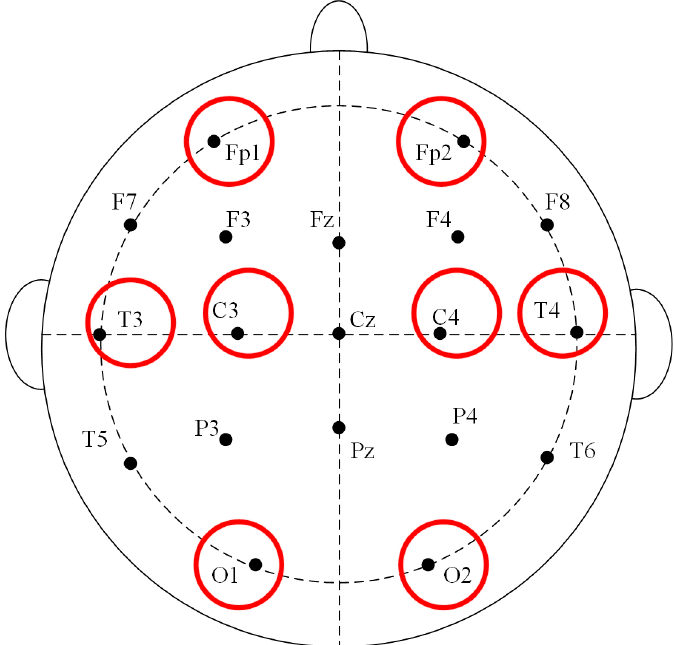
Figure 3. 10–20 electrode system.